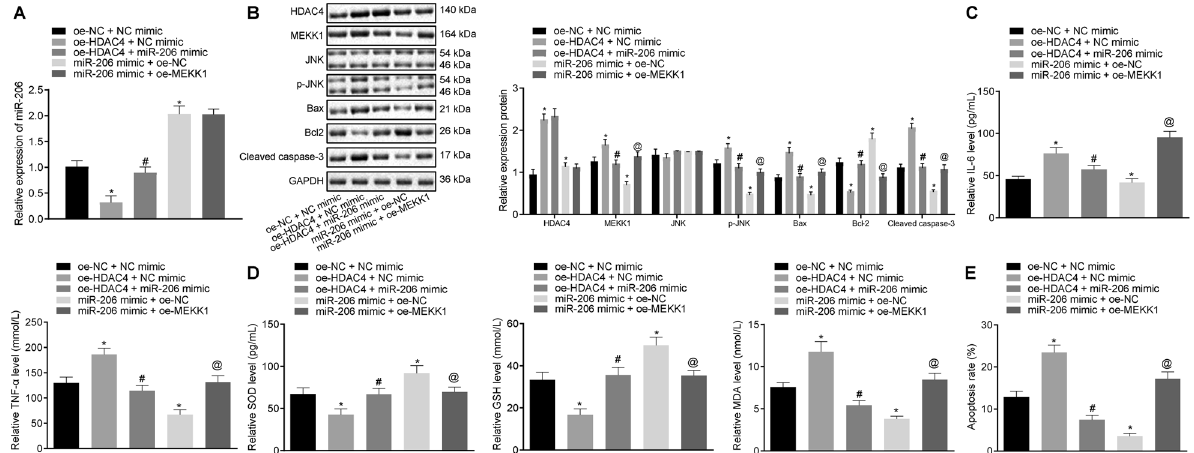
Fig. 5 HDAC4 accelerates cell apoptosis by reducing miR-206 expression and activating the MEKK1/JNK axis in cardiomyocytes from IRI rats. Cardiomyocytes were transfected with oe-NC + NC mimic, oe-HDAC4 + NC mimic, oe-NC + miR-206 mimic, oe-HDAC4 + miR-206 mimic, miR-206 mimic + oe-NC, or miR-206 mimic + oe-MEKK1. A Expression of miR-206 in cardiomyocytes determined by RT-qPCR, normalized to U6. B Protein expression of HDAC4, MEKK1, JNK, p-JNK, Bax, cleaved Caspase-3, and Bcl-2 in cardiomyocytes determined by western blot analysis, normalized to GAPDH. C The levels of IL-6 and TNF- α in cardiomyocytes determined by ELISA. D Determination of SOD, GSH, and MDA contents in cardiomyocytes. E Apoptosis of cardiomyocytes detected by fl ow cytometry. Data were all measurement data and expressed as mean ± standard derivation. Comparisons among multiple groups were analyzed by one-way ANOVA, followed by Tukey ’ s host hoc test. * p < 0.05 vs. the cardiomyocytes co-transfected with oe-NC and NC mimic; # p < 0.05 vs. the cardiomyocytes co-transfected with oe-HDAC4 and NC; @ p < 0.05 vs. the cardiomyocytes co-transfected with miR-206 mimic and oe-NC. The experiment was conducted three times independently.